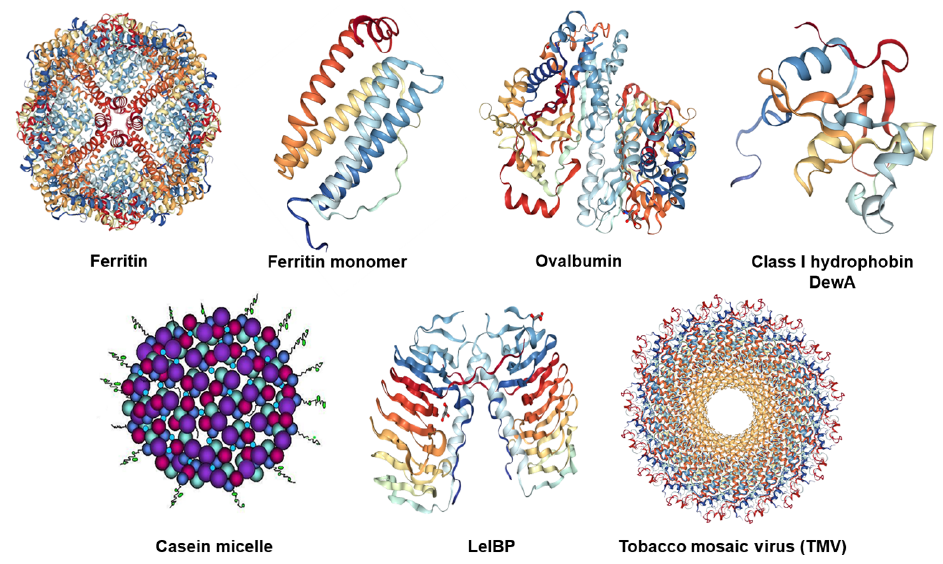
Figure 1. Structures of the investigated proteins and the tobacco mosaic virus: horse spleen (apo)ferritin cage and (apo)ferritin monomer (PDB ID: 4V1W, Russo and Passmore, 2014), chicken ovalbumin (PDB ID: 1OVA, Stein et al., 1991), hydrophobin class I DewA